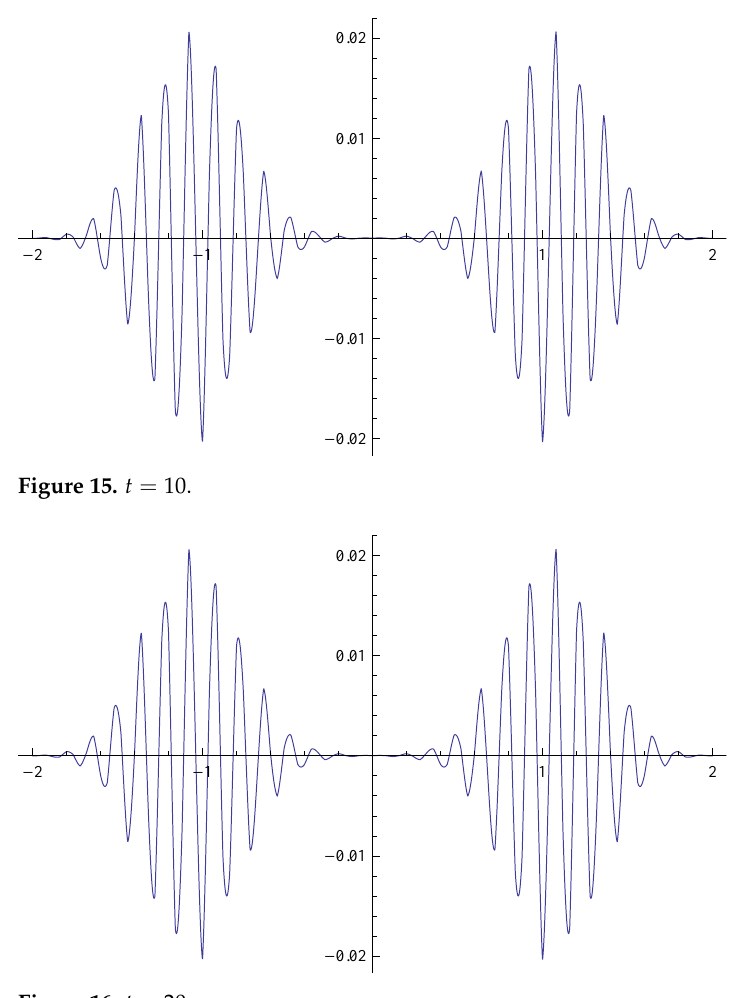
Figure 16. t = 20. The time evolution of y ( n ) of the same equation, but corresponding to γ = 1, β = 1.7, α = 1, and f ( x ) = sin π x , is plotted Figures 17–20. These simulations show that the L approximate solution reaches its stationary solution at t = 20, and it does not change even if we increase the number of iterations till we reach t = 60. This is a necessary property of any stochastic process.